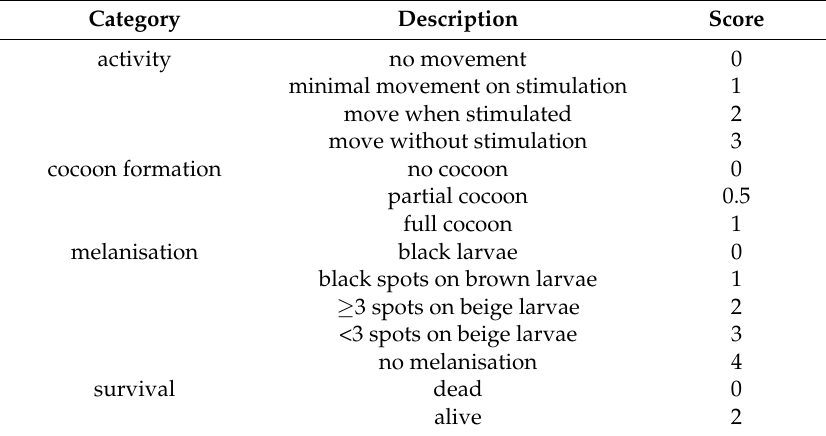
Table 2. The G. mellonella health index scoring system